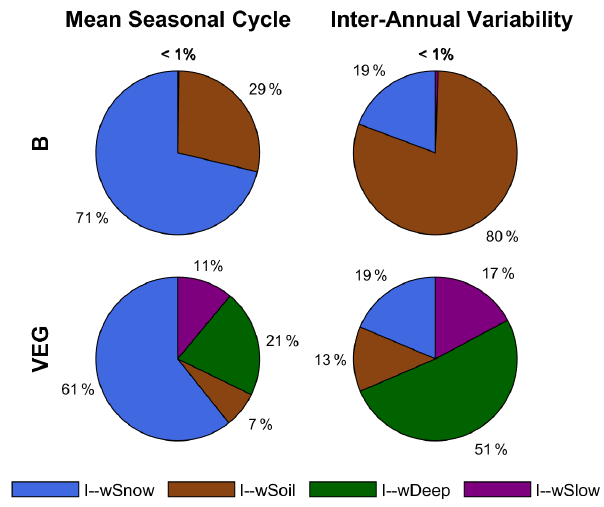
Figure 8. Impact index I for the contribution of simulated snow (wSnow), soil (wSoil), deep water storage (wDeep), and delayed water storage (wSlow) to the global average mean seasonal cycle and inter-annual variability of total water storage, for B and